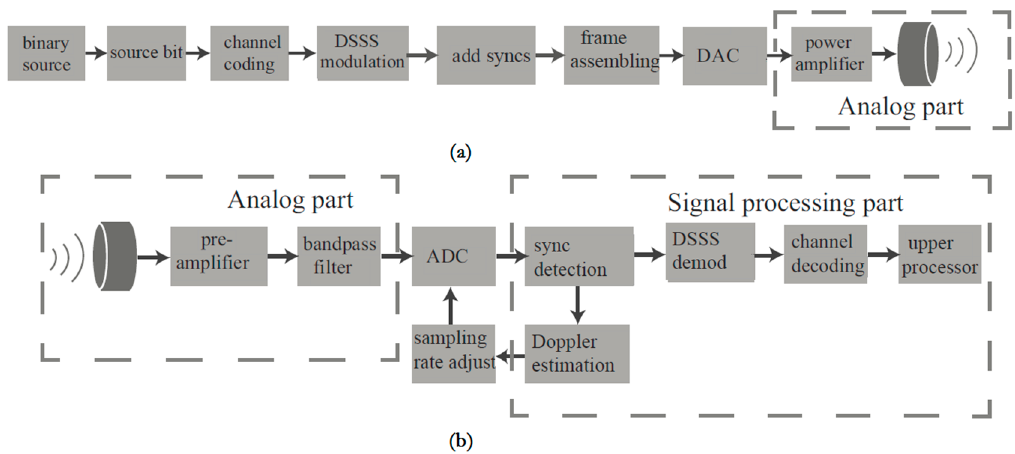
Figure 5. Software flow chart of the receiving.